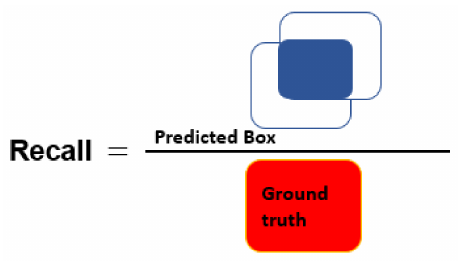
Figure 7. Pictorial representation of